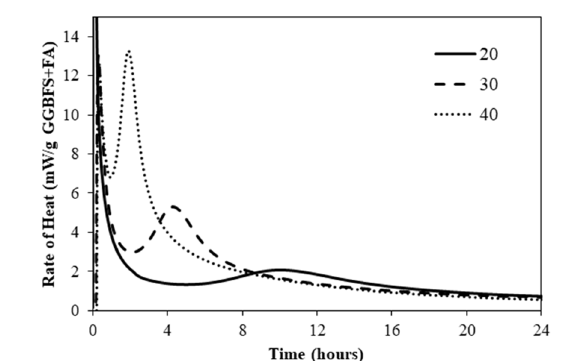
Figure 1. Effect of temperature (20, 30 and 40 °C) on the rate of heat released using isothermal calorimeter. Fig. 2 plots the rate of heat release with respect to the cumulative heat measured with the isothermal calorimeter.